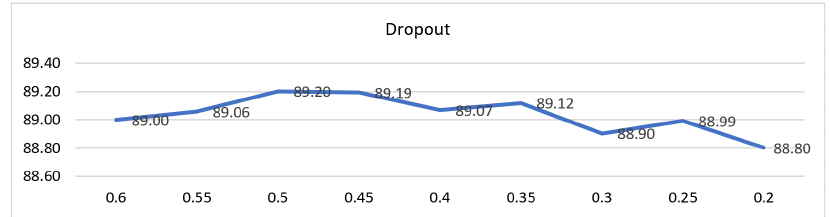
Figure A1. F1 score on NER with difference dropouts. The dropout value of 0.5 achieves the best score in this task (CoNLL